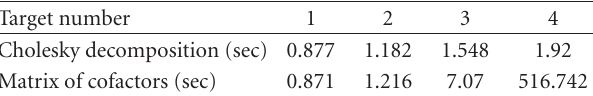
Table 3: Comparison of execution